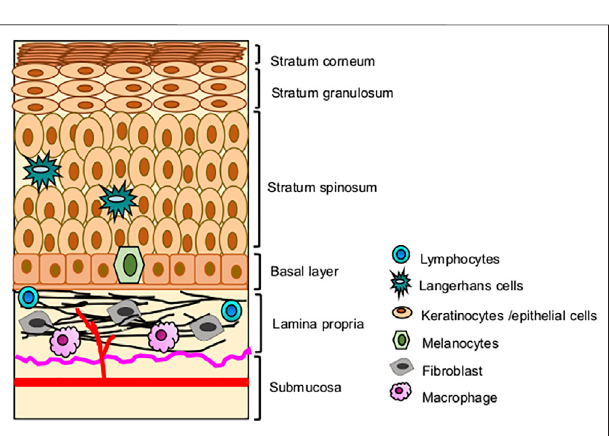
( Figure 1 ) (Rajendran, 2004). In comparison, oral epithelial